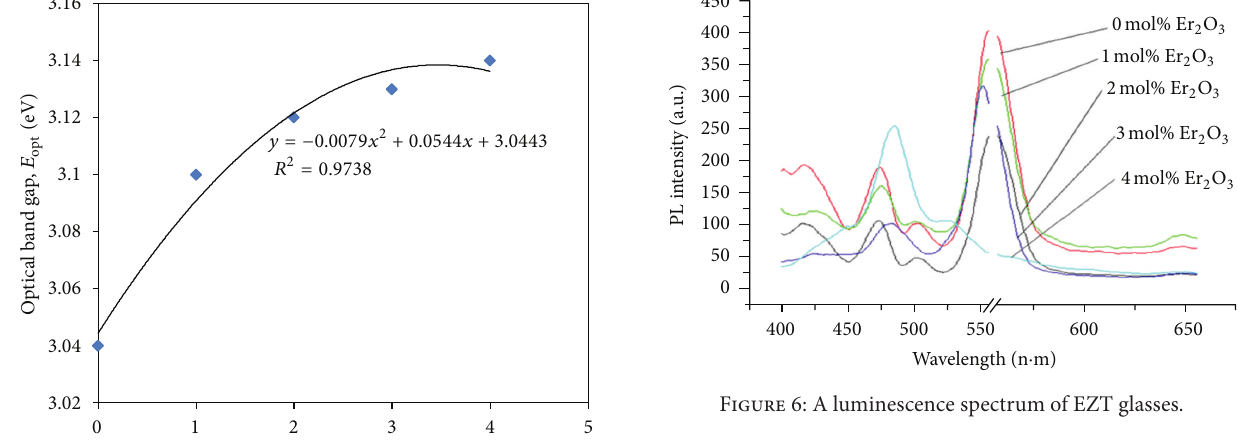
Figure 5: The nonlinear energy gap 𝐸 content.